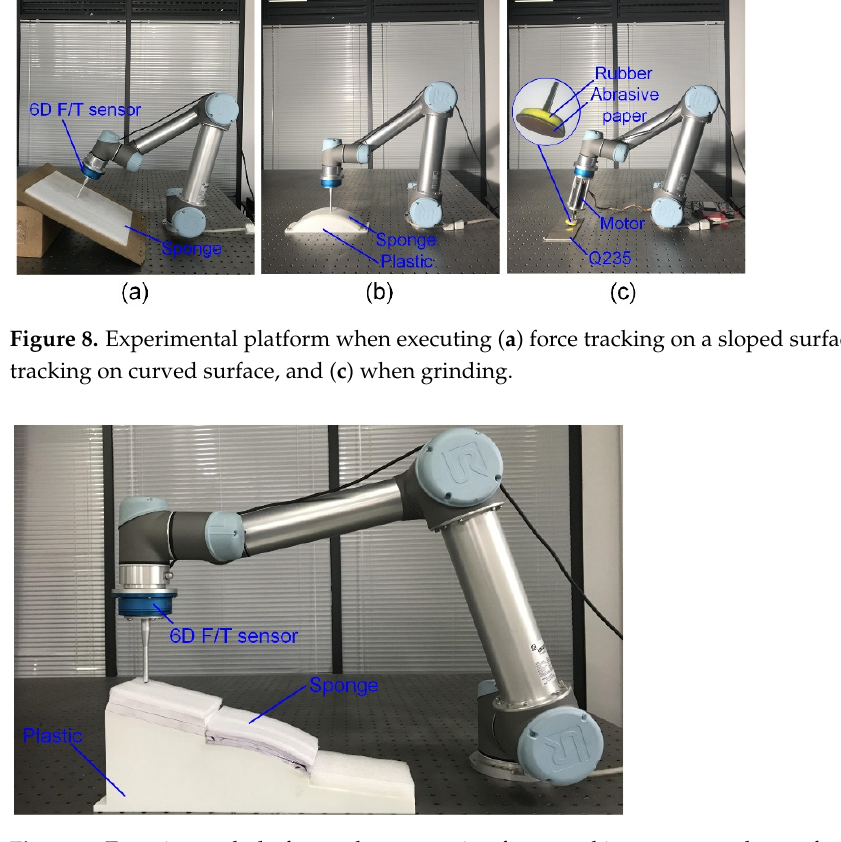
Figure 9. Experimental platform when executing force tracking on a complex surface.